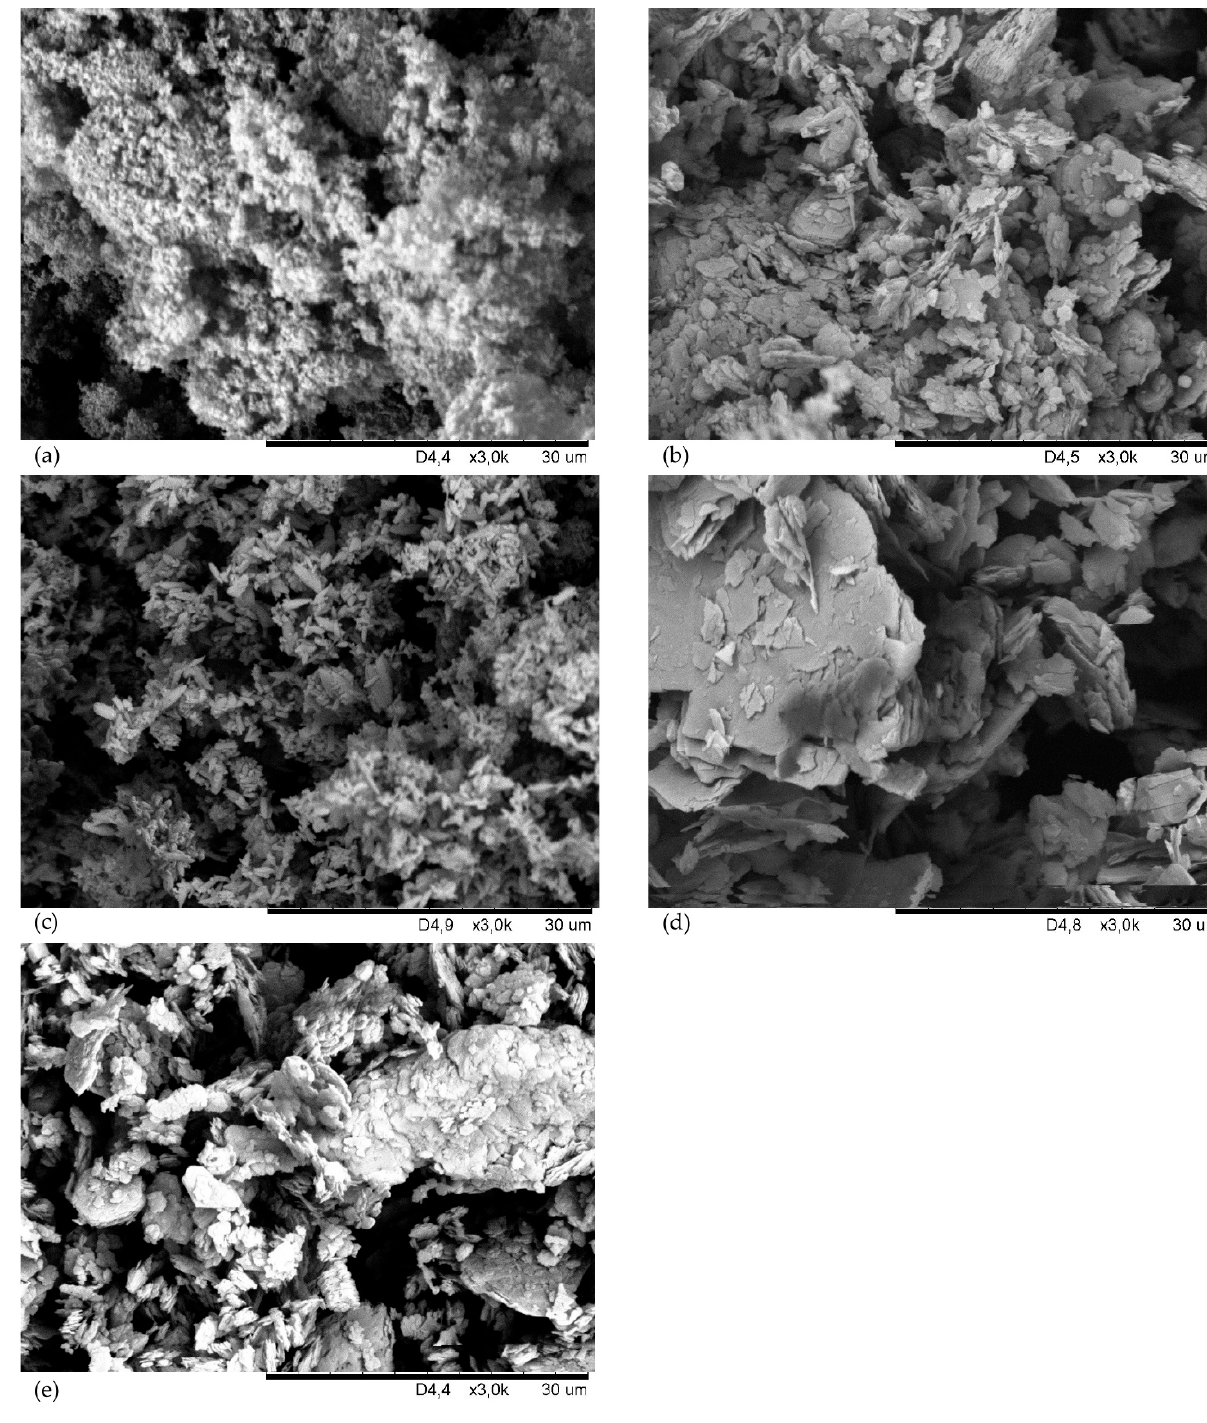
Figure 4. Scanning electron microscope (SEM) images of the fillers used into CSM43: arsil ( a ), kaolin ( b ), chalcedonite ( c ), talc ( d ), carbon clack ( e ).